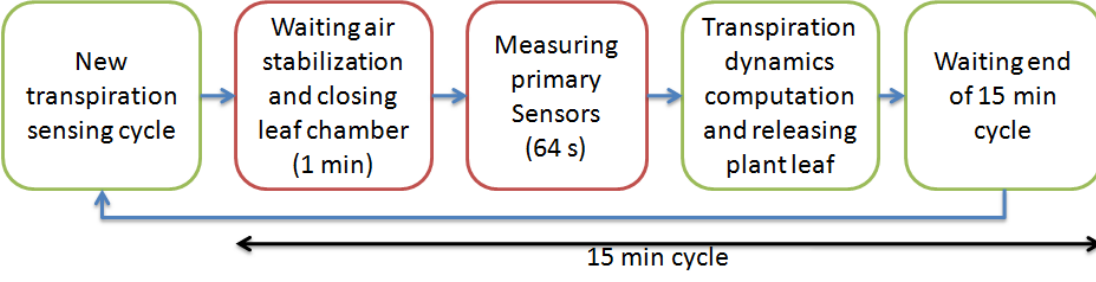
Figure 3. Block diagram of transpiration smart sensing